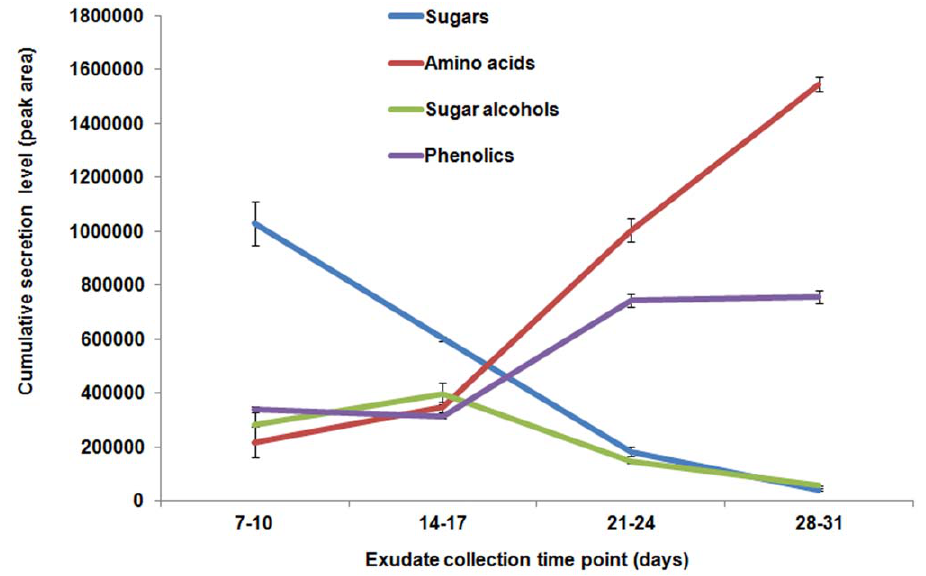
Figure 2. Arabidopsis root exudate composition across development. Identified compounds were grouped into chemical classes, and secretion levels were calculated based on cumulative peak area after normalization.